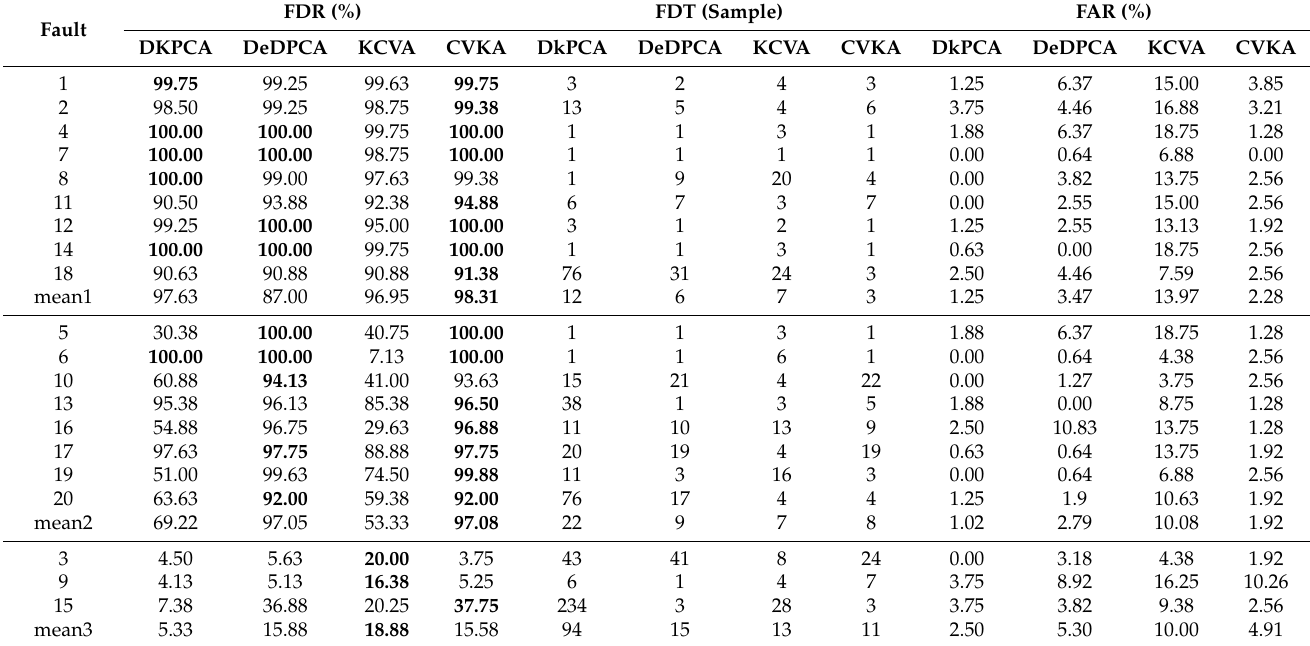
Table 1. FDRs, FDTs and FARs of 20 TE faults using DKPCA, KCVA, DeDPCA and